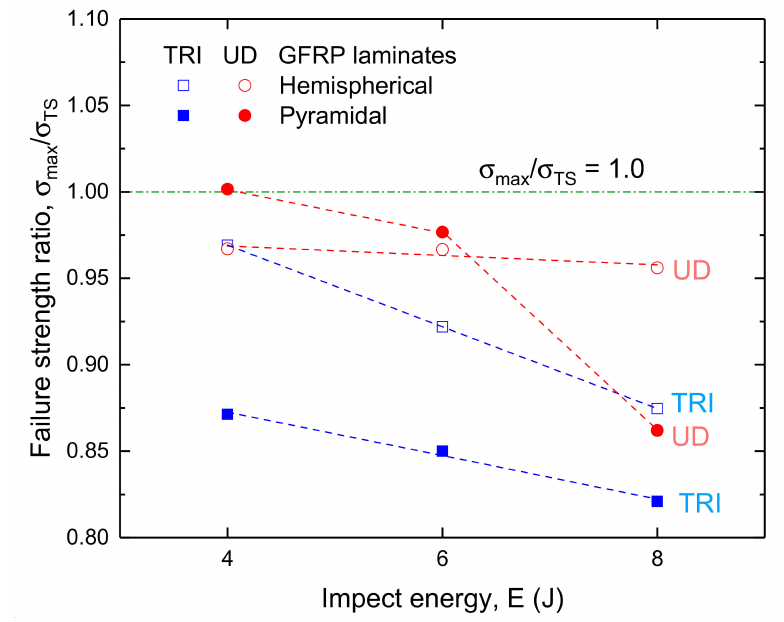
Figure 8. Dependency of residual strength of the impacted GFRP laminates on the impact energy and impact indent